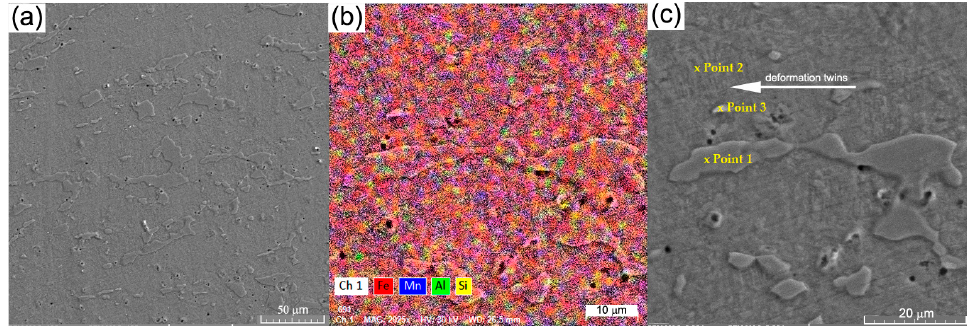
Figure 2. SEM images of the FeMnSi-Al structure: ( a ) structure; ( b ) elemental distributions; ( c ) area selection for the phase chemical composition determination. selection for the phase chemical composition